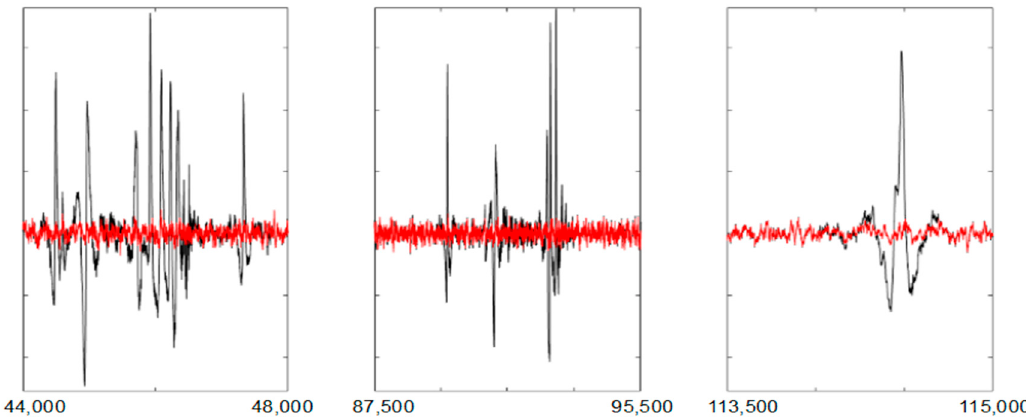
Figure 7. Three sequences of artefacts in the AF8 channel. In red, the filtered signal. The X axes show the samples.